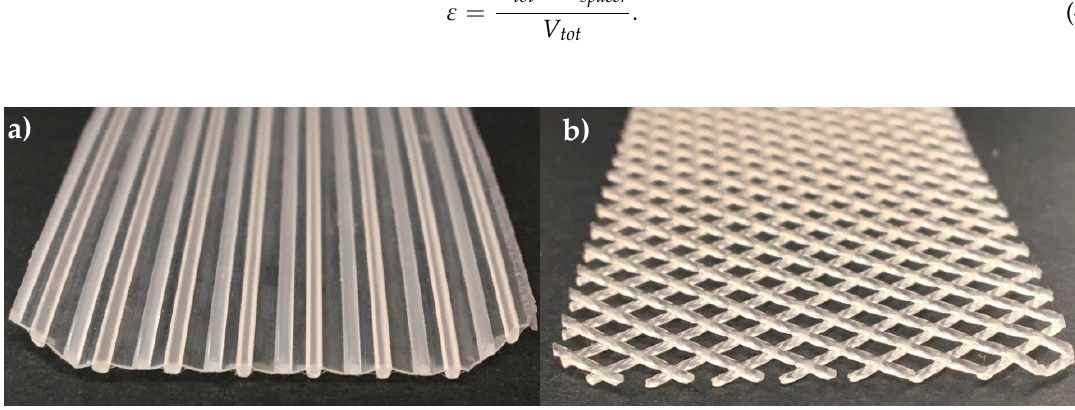
Figure 3. Geometry of the parallel ( a ) and the diamond spacer ( b ).